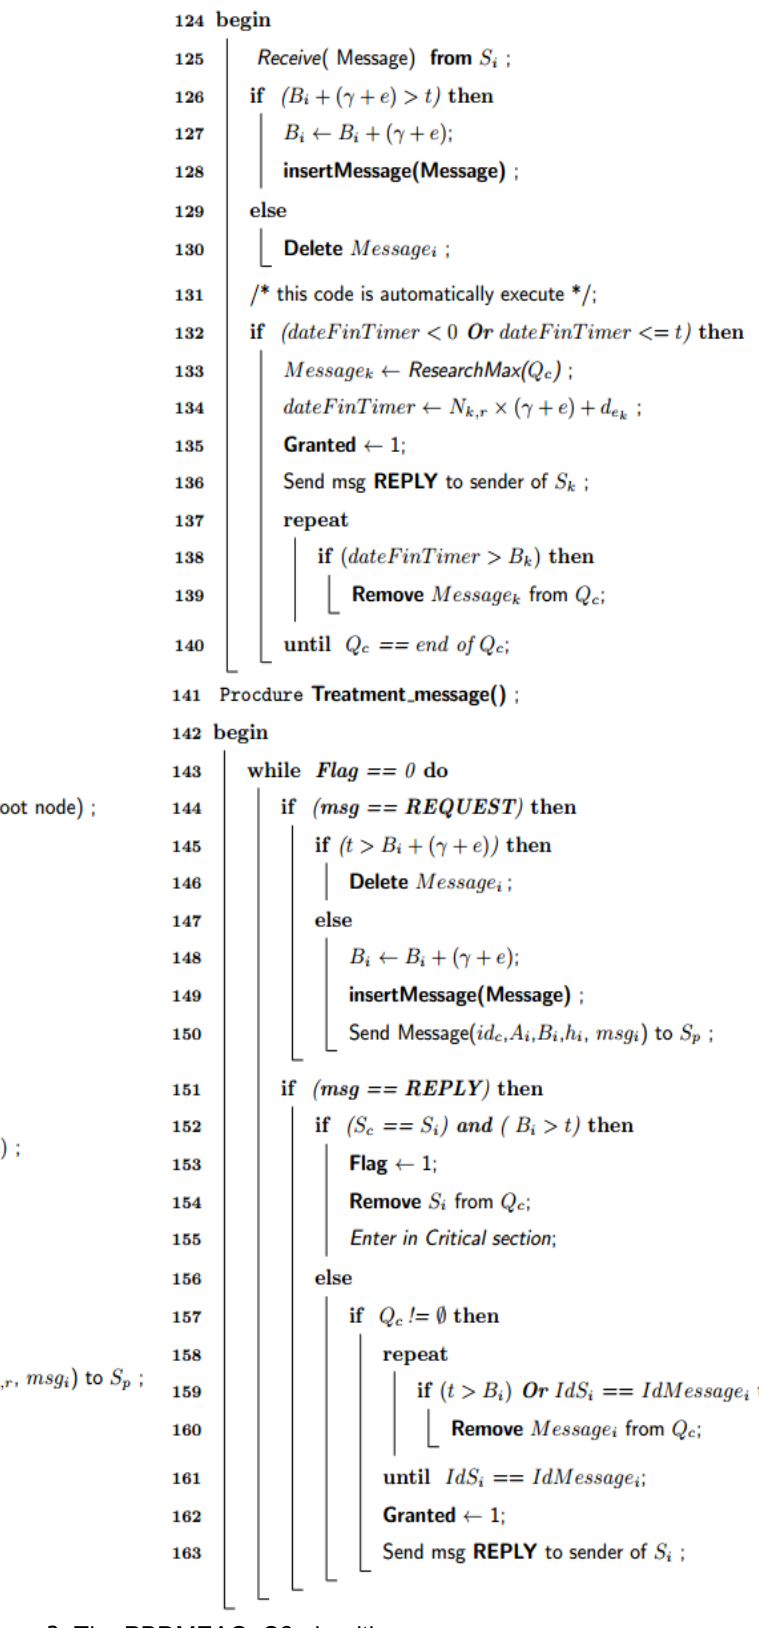
Figure 3 : The PBDMEAQoSβ